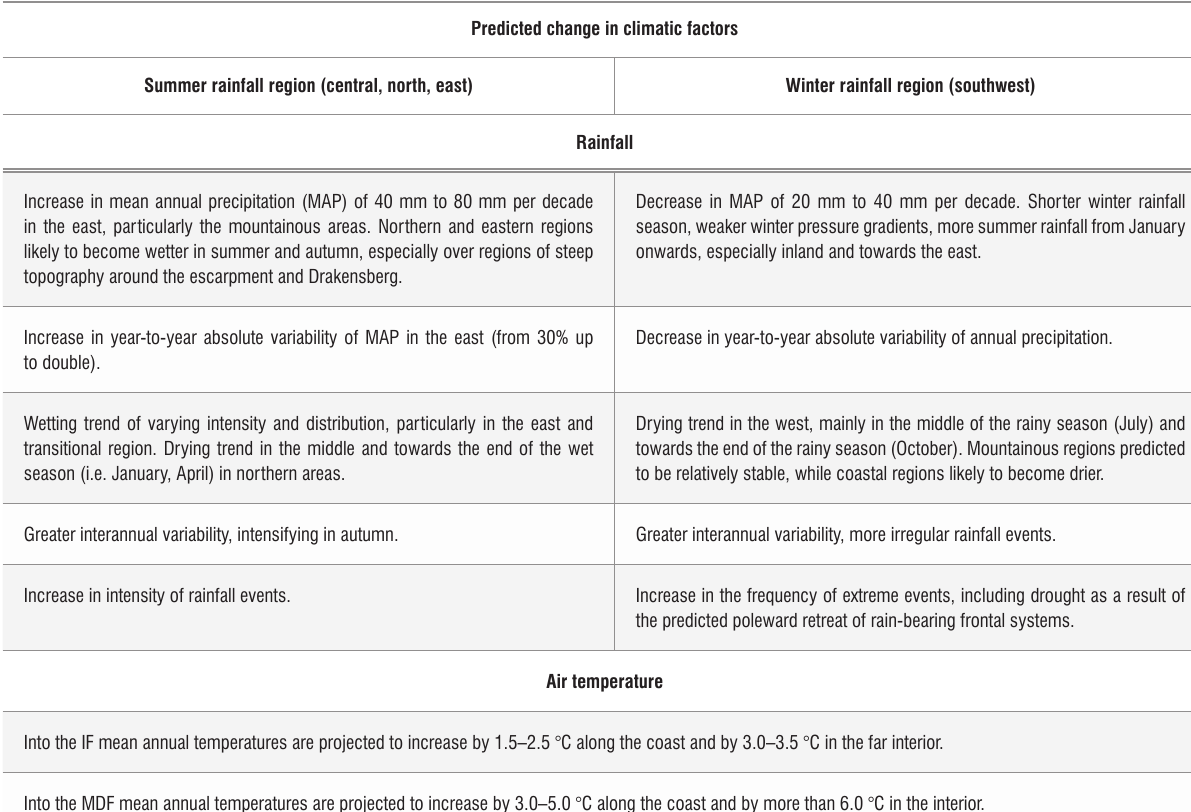
Predicted change in climatic factors Summer rainfall region (central, north, east) Winter rainfall region (southwest)